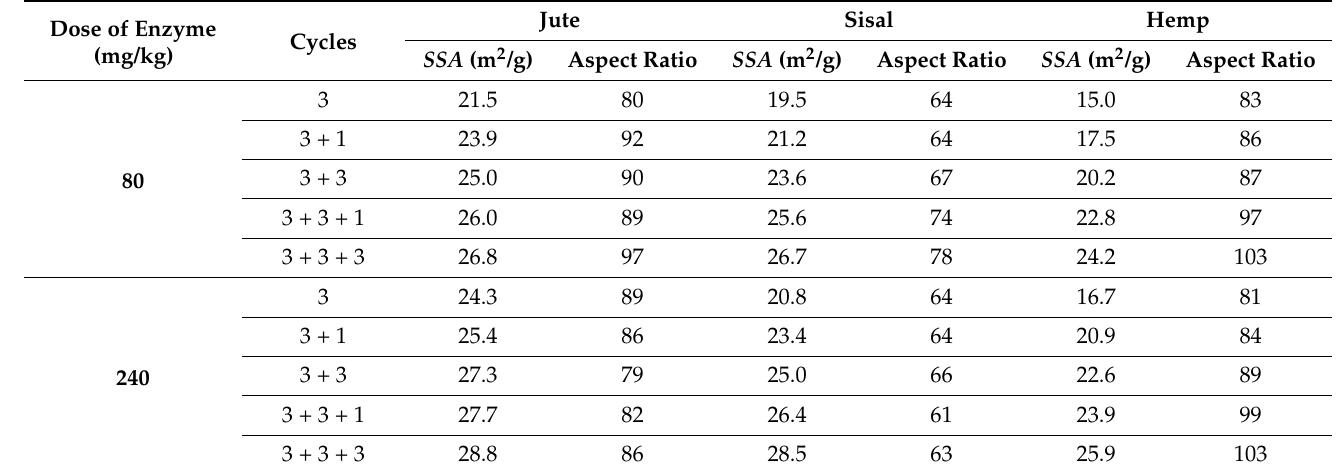
Table 3. Effect of the number of HPH cycles on the specific surface area and the aspect ratio of MNFCs that underwent enzymatic hydrolysis.